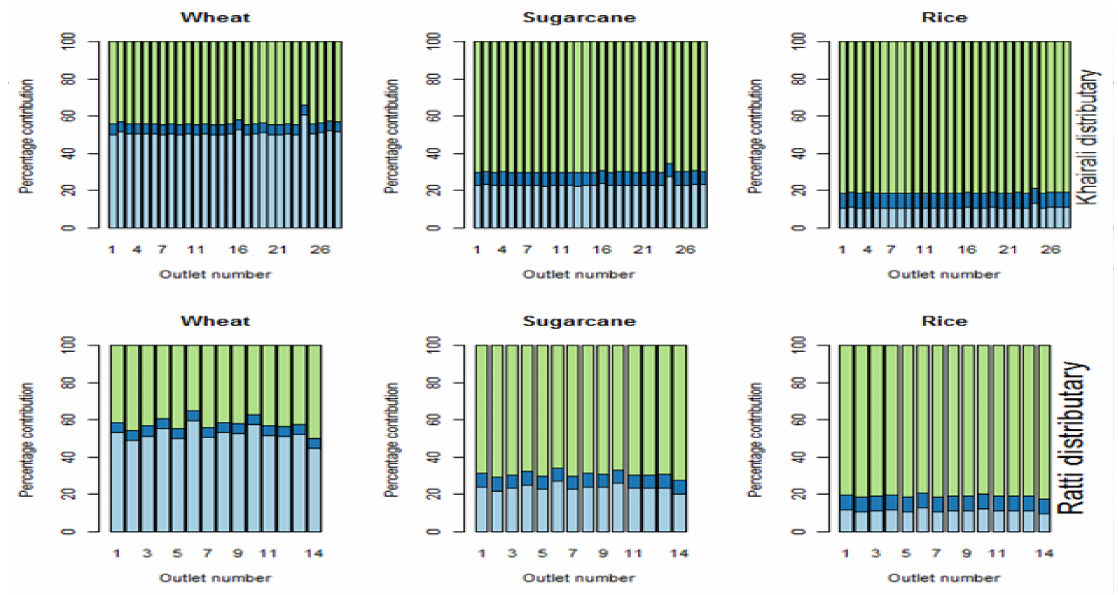
Figure 6. Percentage contribution of canal, tubewell and rainfall in irrigating selected crops of the study area.